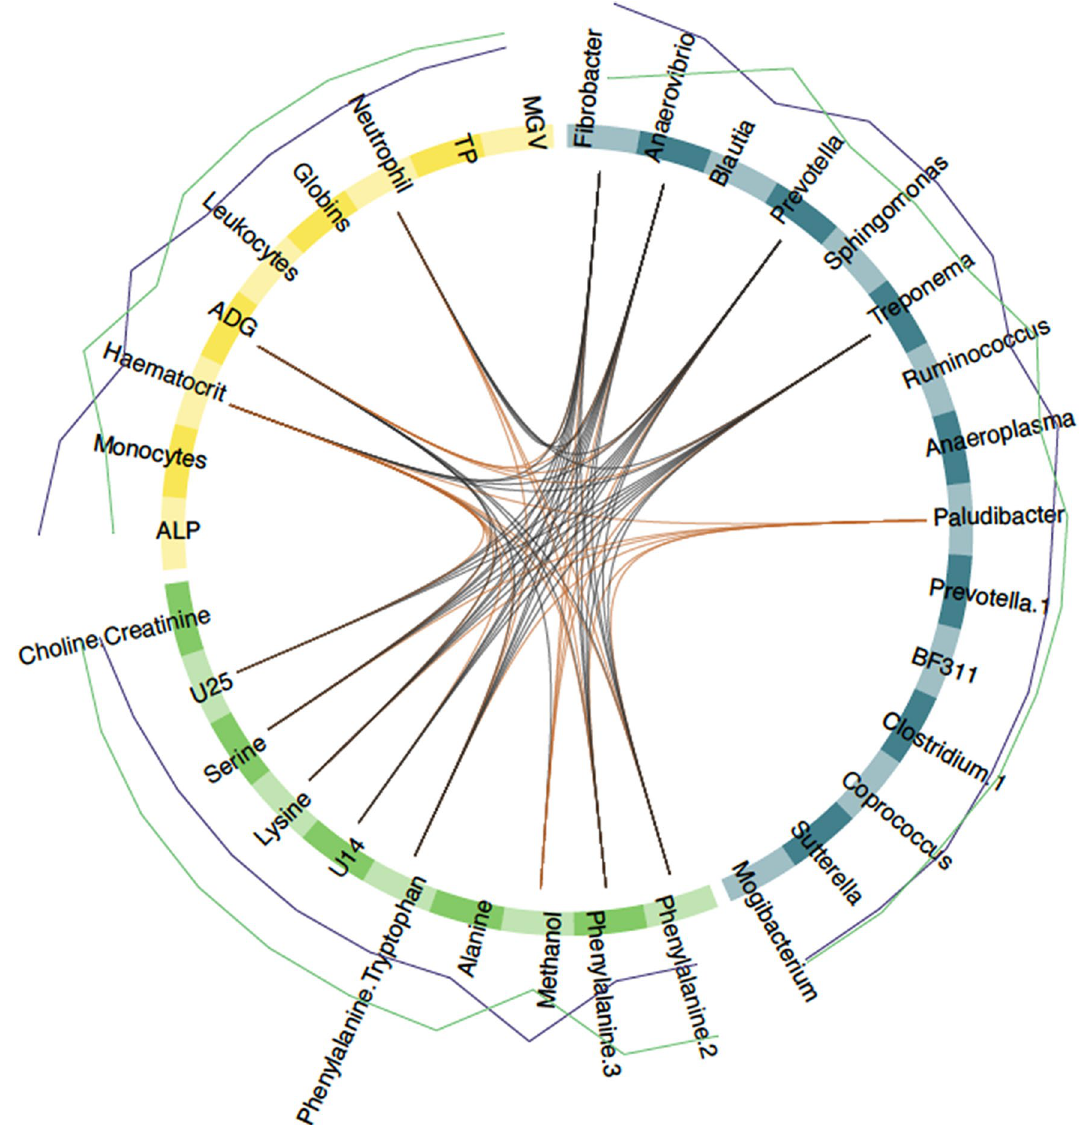
Figure 4. Circos plot showing features best discriminating between infected resistant and susceptible ponies (day 132). For each of the three input data types (clinical data in yellow, bacterial genera in purple and metabolite signals in orange), the features best discriminating between resistant and susceptible ponies are listed. A link is materialized between two features if their shared correlation is above 0.45 (chocolate if positive, grey otherwise). External green and purple lines represent the relative feature level in each pony susceptibility group (resistant, TR: purple; susceptible, TS: green). MGV mean globular volume, TP total protein, ALP alkaline phosphatase, U14, U25 unknown metabolites 14 and